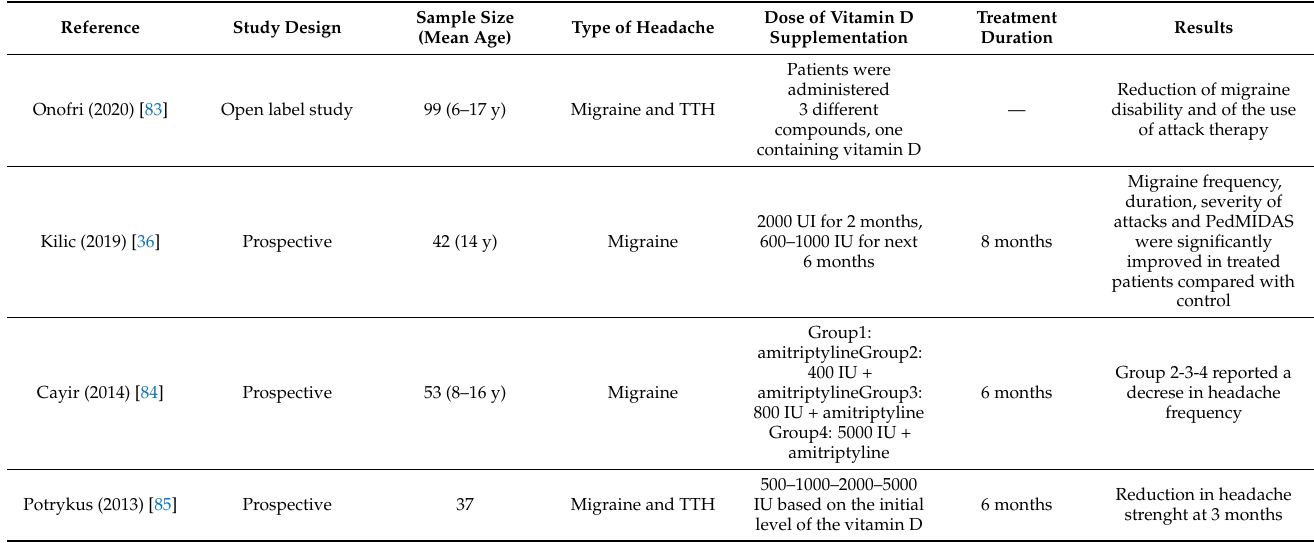
Table 2. Vitamin D Profilaxis in Pediatric